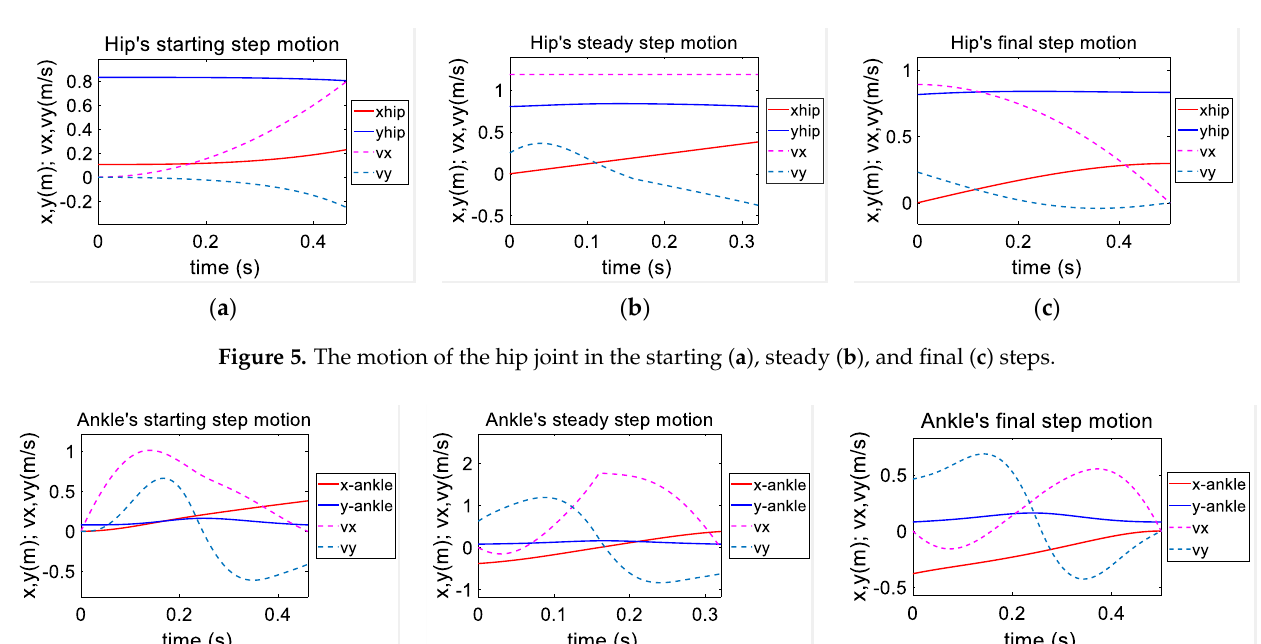
Figure 6. The motion of the ankle joint in the starting ( a ), steady ( b ), and final ( c ) steps. Figure 5a – c shows the position and velocity of motion over time of the hip joint at the starting, steady, and final steps, respectively. Similarly, the movement over time of the ankle joint is shown in Figure 6a – c.